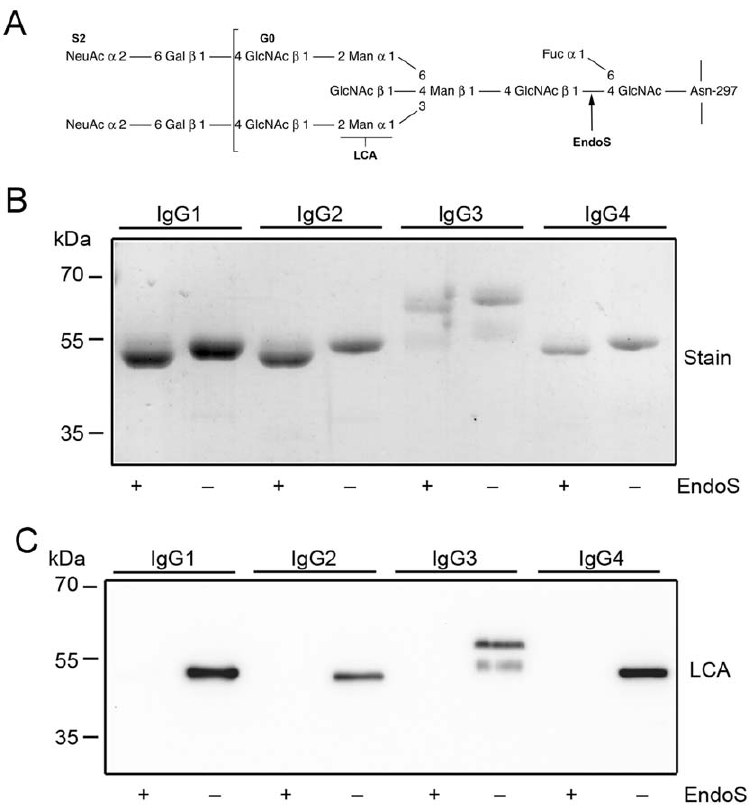
Figure 1. EndoS has glycosidase activity on all four human IgG subclasses. Panel A . Glycan structure of human IgG. Glycan on the c 2 chains of IgG attached to aspargine 297. GlcNAc, N -acetylglucosamine; Fuc, fucose; Man, mannose; Gal, galactose; NeuAc, sialic acid. Cleavage site for EndoS and recognation site for Lens culinaris agglutinin lectin (LCA) are indicated. Panel B. Purified IgG 1–4 incubated with EndoS and analyzed by SDS-PAGE and stained. Panel C. IgG 1–4 incubated with EndoS and analyzed using LCA lectin blot.